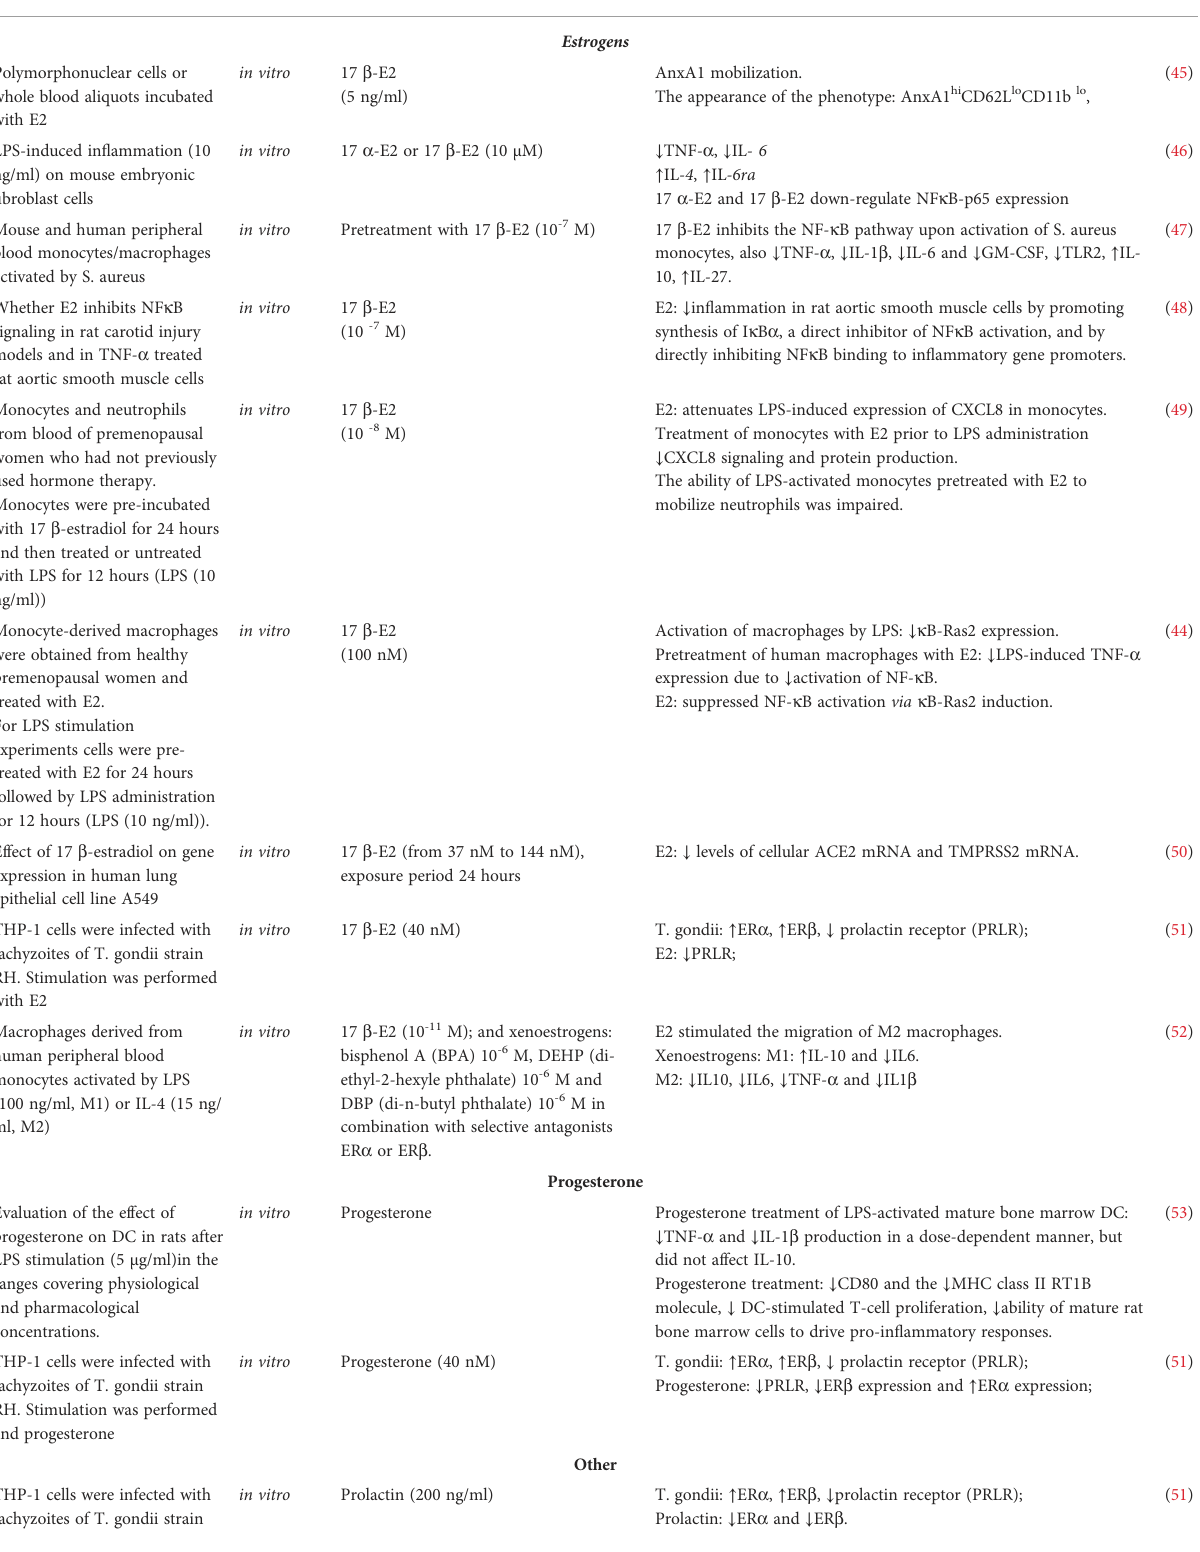
TABLE 1 Immunity-related effects of sex hormones observed mainly in vitro .